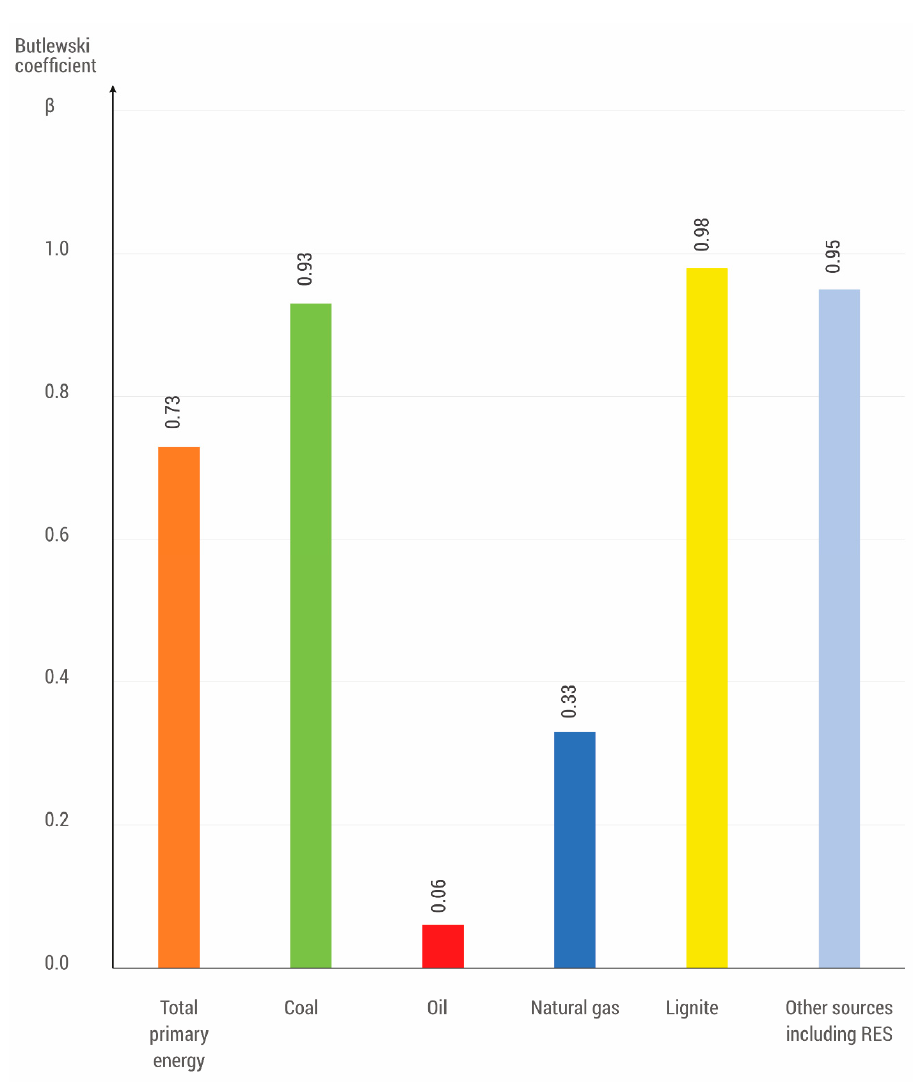
Figure 3. The Butlewski coefficient β for various energy carriers in Poland in 2019. RES—renewable energy sources.